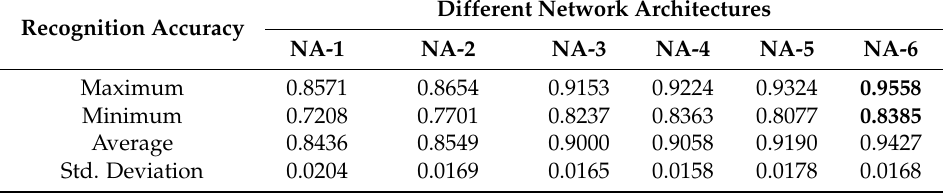
Table 3. List of trainable parameters in each network architecture.